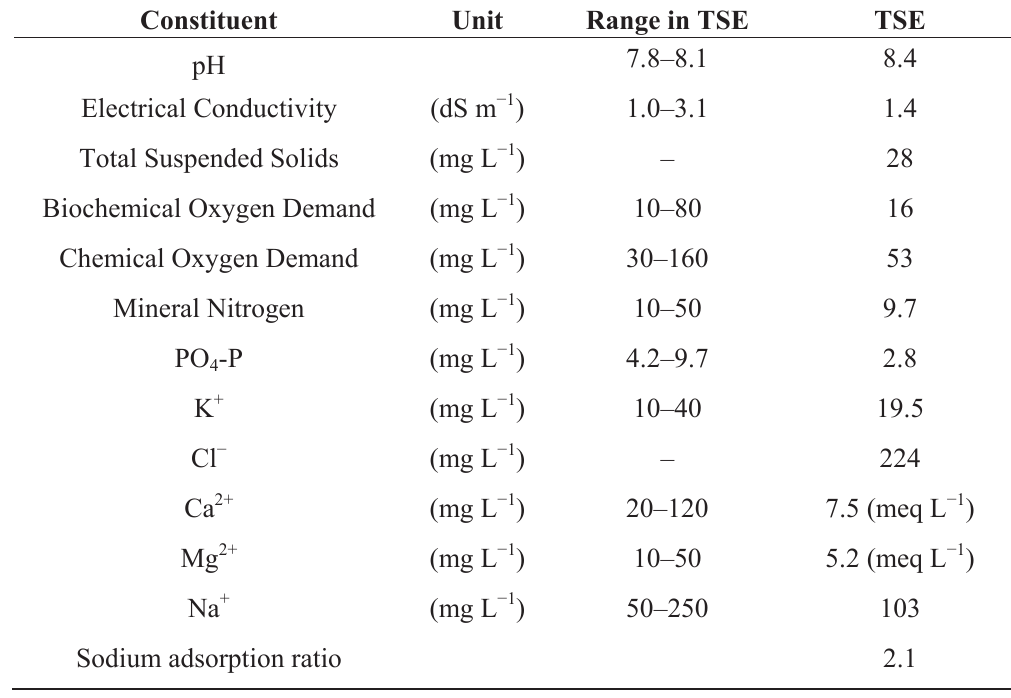
Table 5. Average values for physical and chemical characteristics of treated sewage effluent (Range in TSE) from different studies in the world [8,34,55–57]. Average values of treated sewage effluent (TSE) from a wastewater treatment plant in Benslimane, Morocco